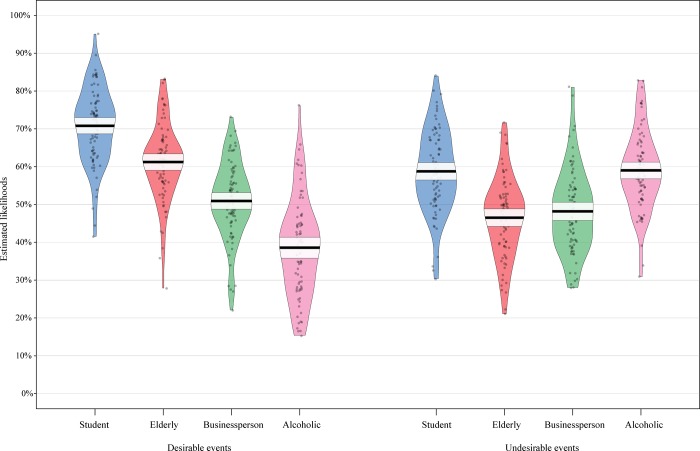
Pirate plots of the likelihood estimates that each character received for desirable and undesirable events.Dark horizontal lines reflect the sample mean. Horizontal bands around the sample mean reflect 95% confidence interval.